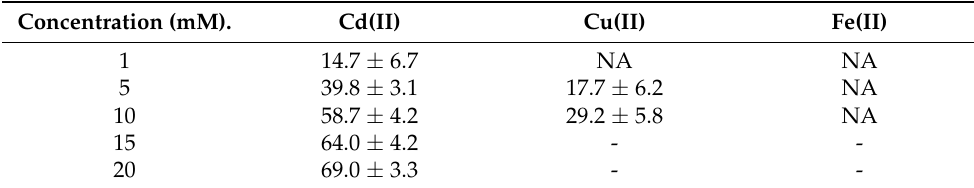
Table 2. Chelating activity (%) of AL14 for Cd(II), Cu(II), and Fe(II). Concentration (mM).